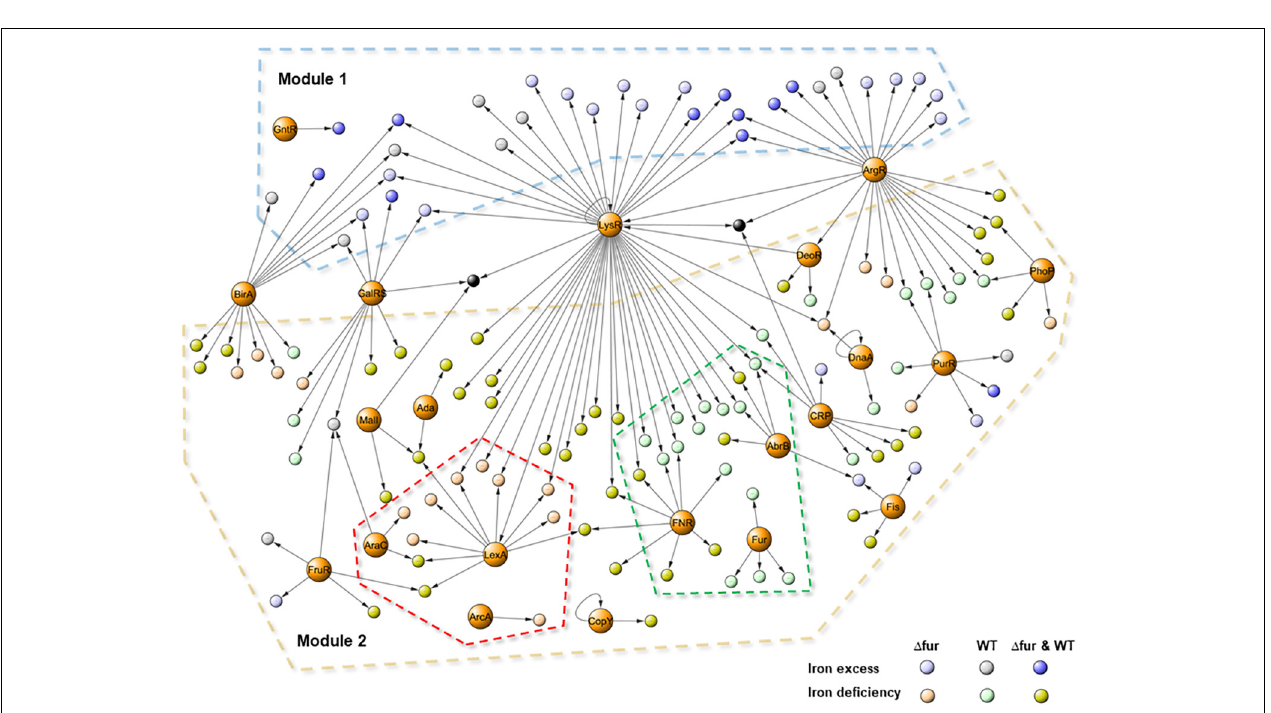
FIGURE 5 | Transcriptional regulatory network activated by iron excess and deficiency in E. faecalis wild type and (cid:49) fur (Fur mutant). The graph contains 153 nodes (139 activated operons and 21 family of regulators) connected by 181 edges (putative binding sites). Color circles represent differentially expressed responses of each operon in the RNAseq experiment. Dash lines indicate: Module 1 (iron excess) in light blue, Module 2 (iron deficiency) in light brown, wild type sub-network in light green and (cid:49) fur in light pink.